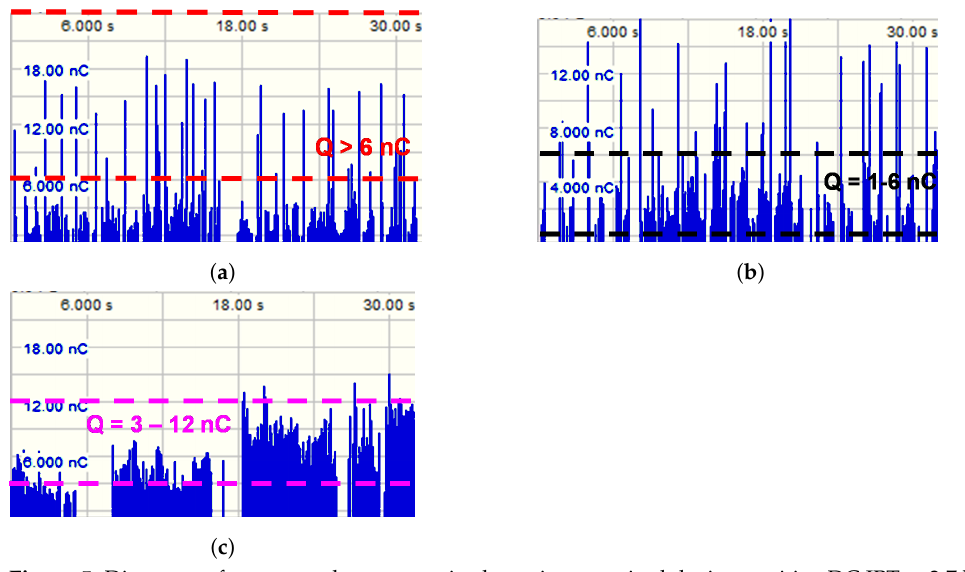
Figure 5. Diagrams of apparent charge magnitude vs time acquired during positive DC IPT at 2.7 kV. ( a ) Mobile discharges producing magnitudes greater than 6 nC. ( b ) Localized discharges producing magnitudes between 1 nC and 6 nC. ( c ) High temperature discharges having a magnitude window between 3–12 nC.